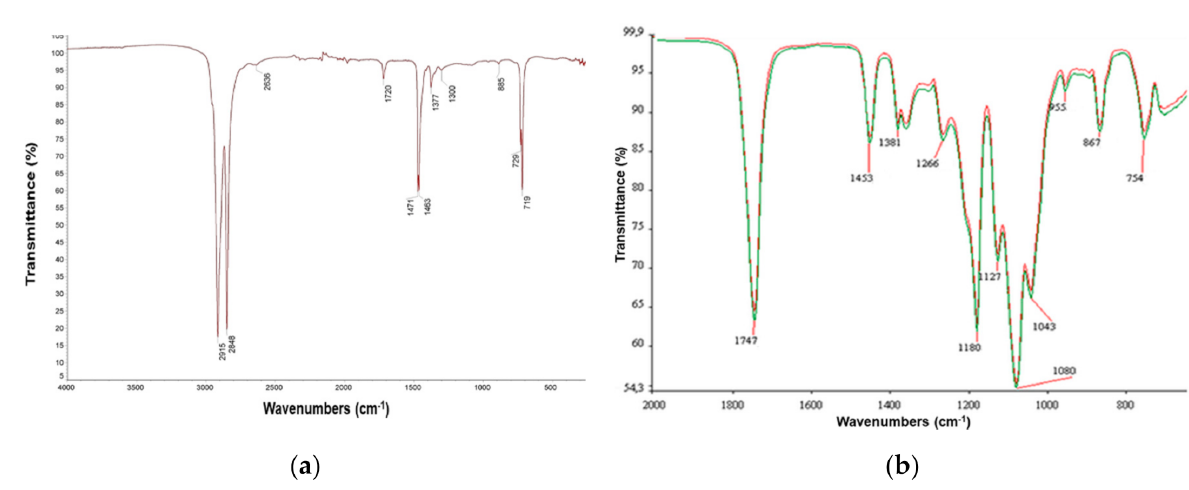
Figure 3. FTIR spectrum of polyethylene (PE) ( a ) and of PLA ( b